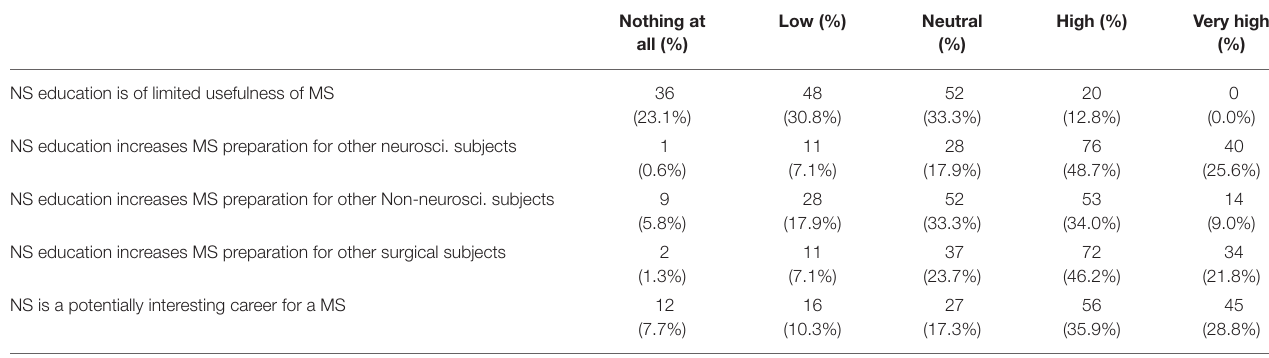
TABLE 6 | Usefulness of neurosurgery in medical students’ career.